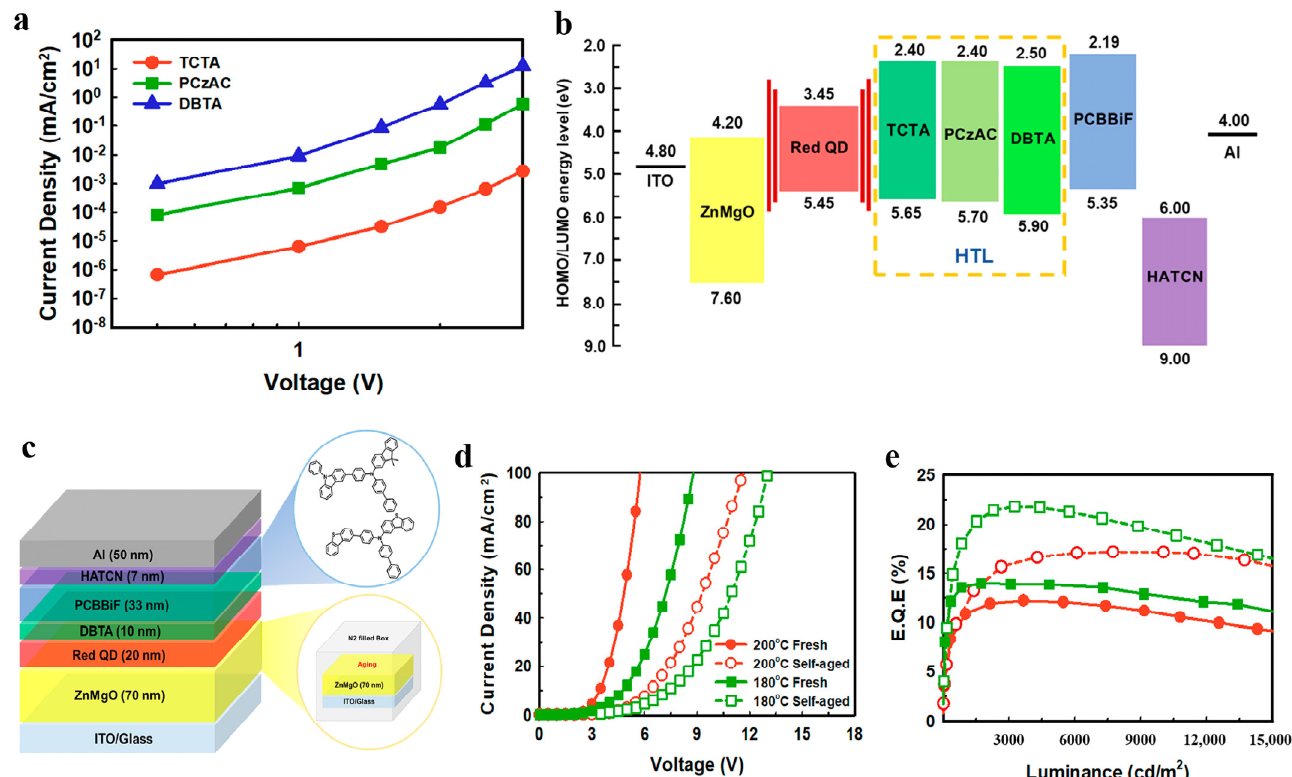
Figure 14. ( a ) Current density − voltage curves for different HTL materials. ( b ) Device structure and HOMO and LUMO energy levels of each part. ( c ) Schematic diagram of the device structure. EL performance: ( d ) current density − voltage and ( e ) EQE − brightness curves of QLEDs fabricated with Zn 0.83 Mg 0.17 O layers by different processes. Reprinted with permission from Ref. [23]. © 2020, Amer- ican Chemical Society.